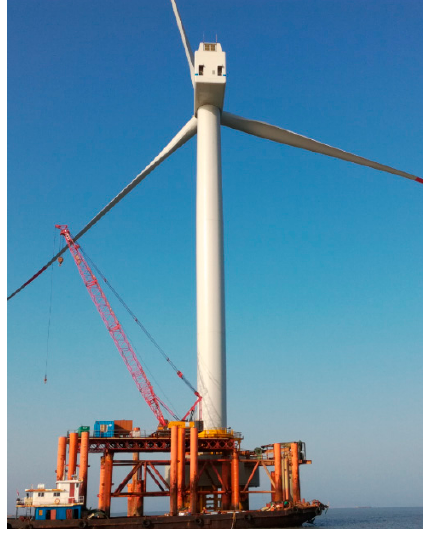
Figure 2. DEW-G5000 wind turbine in position Y14.